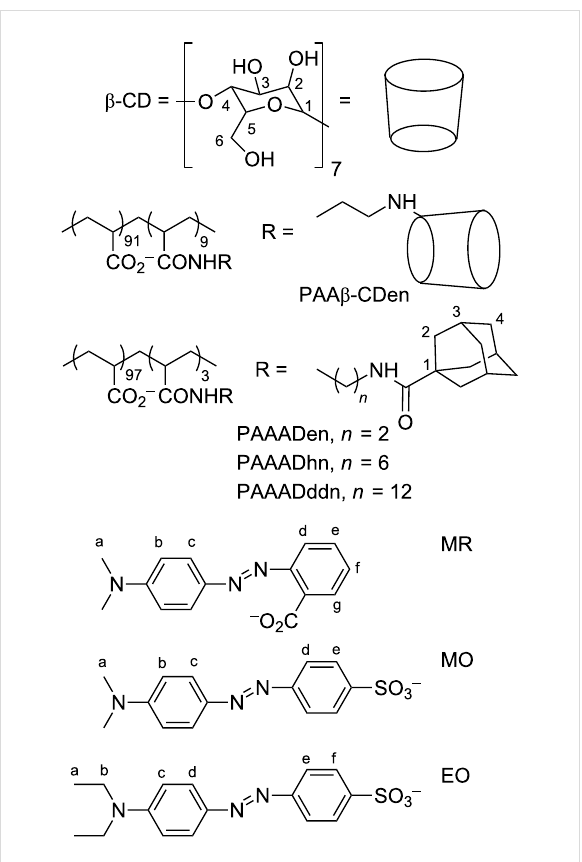
Figure 1: β -Cyclodextrin- and adamantyl-substituted poly(acrylate)s PAA β -CDen, PAAADen, PAAADhn, and PAAADddn (carbon atoms labelled numerically), and the anionic dyes methyl red, MR, methyl orange, MO, and ethyl orange, EO (carbon atoms labelled alphabeti-